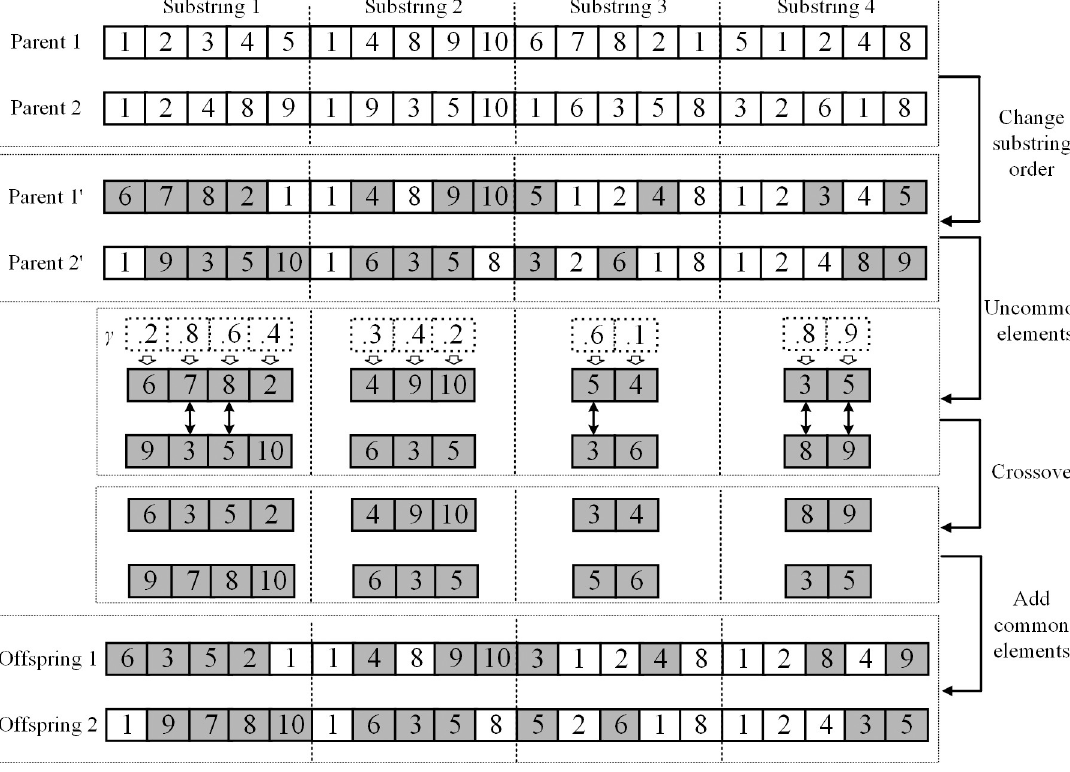
Fig 7. The crossover operation. Grey elements represent genes that differ between the two parental chromosomes. The substrings of two parent chromosomes are first disorganized, and we check all elements that differ between the two parental chromosomes. If the random number γ < 0.5, the element remains unchanged in the offspring chromosomes, while if γ � 0.5, the corresponding elements are